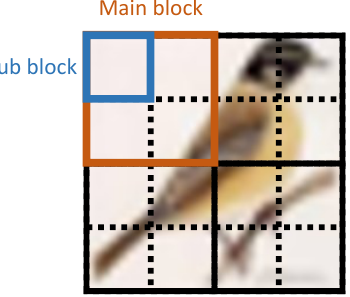
Figure 5. Main-block and sub-block